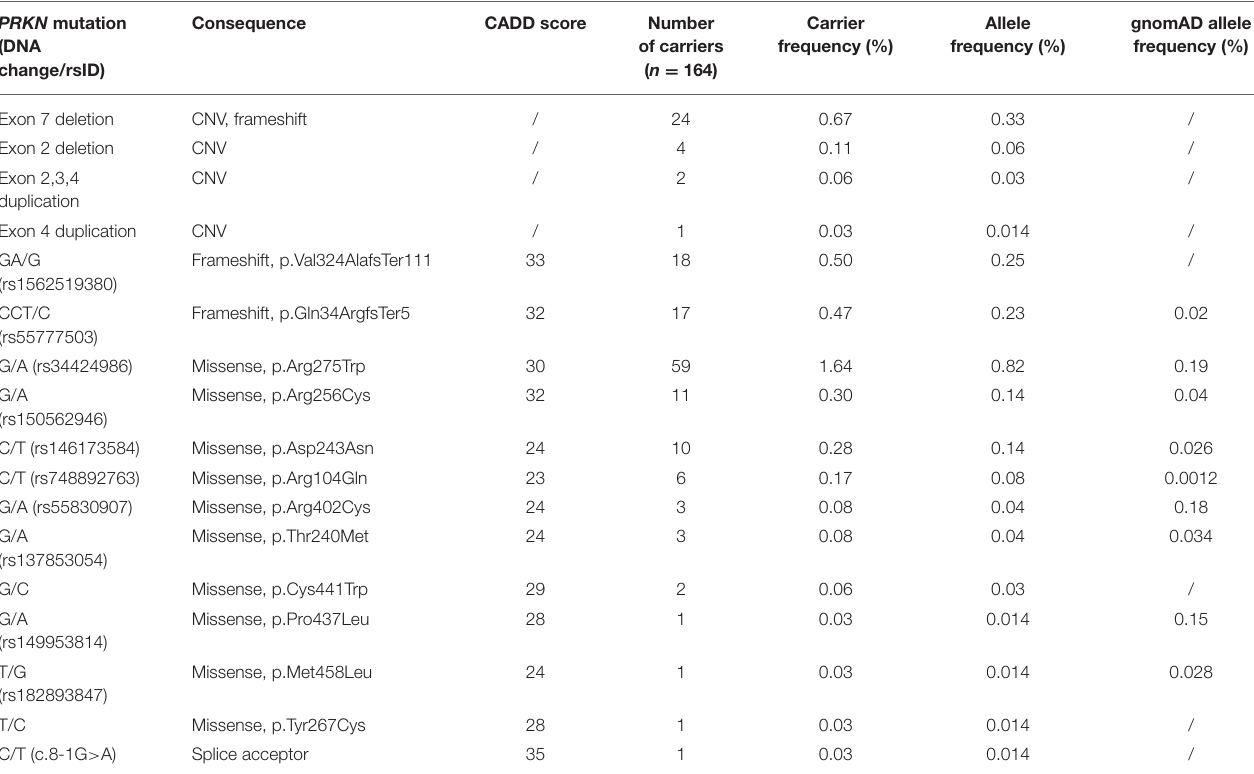
TABLE 1 | Heterozygous mutations in the PRKN gene identified in the exome sequenced dataset of the CHRIS cohort ( n = 3,603). PRKN mutation (DNA